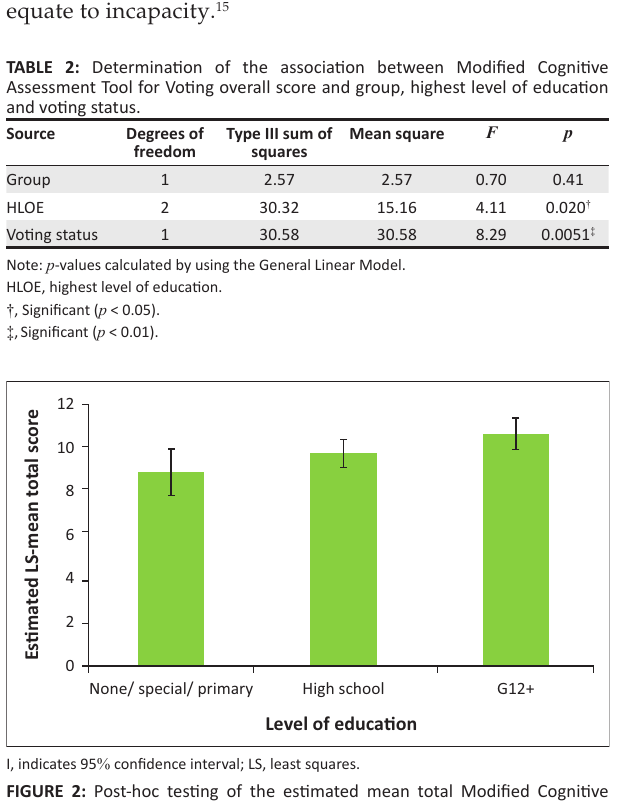
FIGURE 2: Post-hoc testing of the estimated mean total Modified Cognitive Assessment Tool for Voting scores with associated level of education.